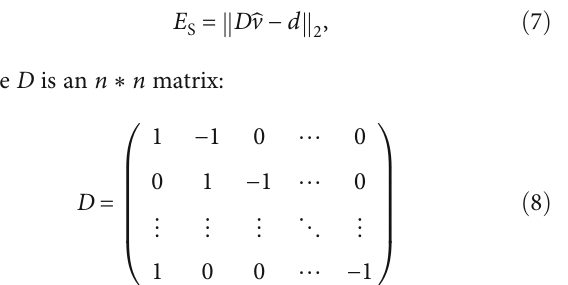
After times the crowd, generate the triangular mesh, the yellows are the vertices of cage